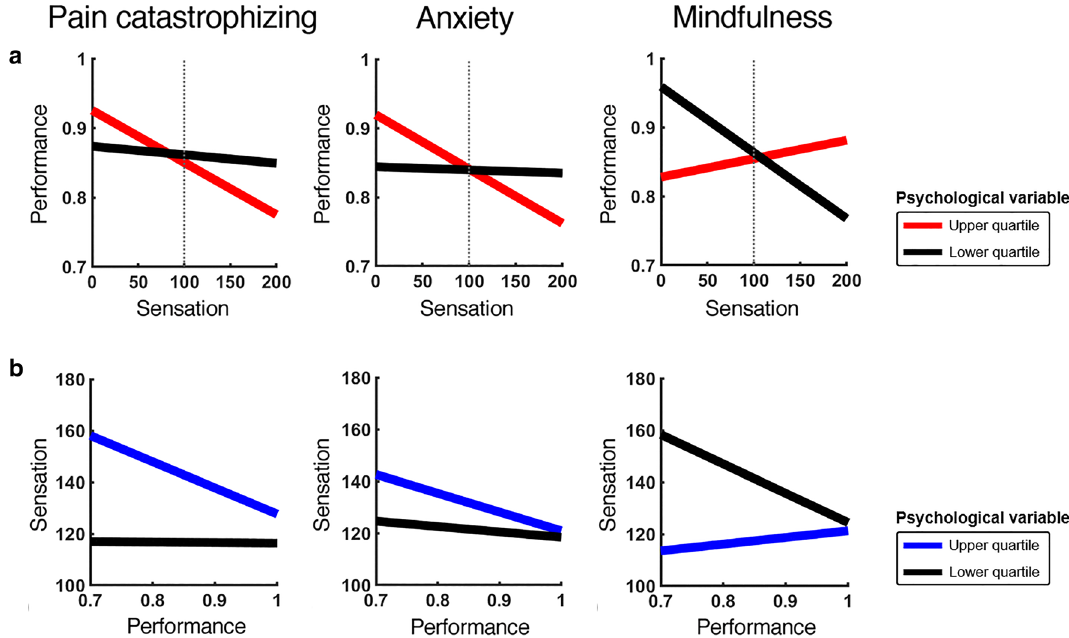
Figure 4. Effects of psychological variables on the trade-off between thermal sensation and performance. Linear functions were estimated using coefficients from the output of the multilevel models displayed in Table 2 (see supplementary material for more information on these analyses). Coloured lines (red, blue) depict the sensation–performance relationship for the upper quartile of participants (n = 10) within the indicated moderator, and black lines depict the lower quartile of participants (n = 10). In red, task performance as a function of sensation in an individual trial (i.e., the b path in the pain interference model above), after controlling for the effects of heat level; in blue, sensation as a function of performance (i.e., the b path in the task analgesia model above), after controlling for the effects of task difficulty level. Dotted gray vertical lines represent the pain threshold at sensation ratings level